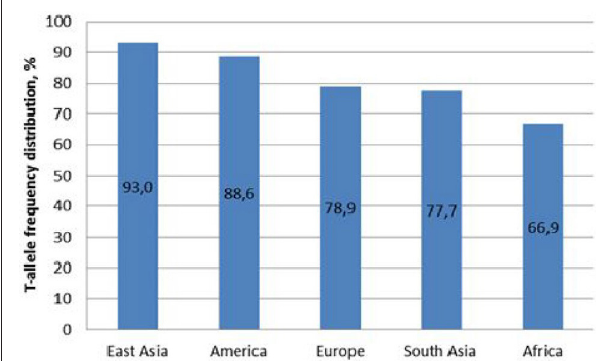
FIGURE 1 | T-allele frequency of MIR137 rs1625579 polymorphism in world populations. Comment: East Asia is represented with Chinese, Japanese and Vietnamese populations; America with Columbian, US (subjects of Mexican origin living in Los Angeles), Peruvian, and Puerto-Rican populations; Europe with Finnish, British, Spanish, Italian populations and subjects of European origin living in Utah state; South Asia with Bangladesh, Pakistani populations and subjects living in US and UK originating from India and Sri Lanka; Africa with Kenyan, Nigerian, Gambian, Sierra-Leonean populations and subjects of African origin living in US and